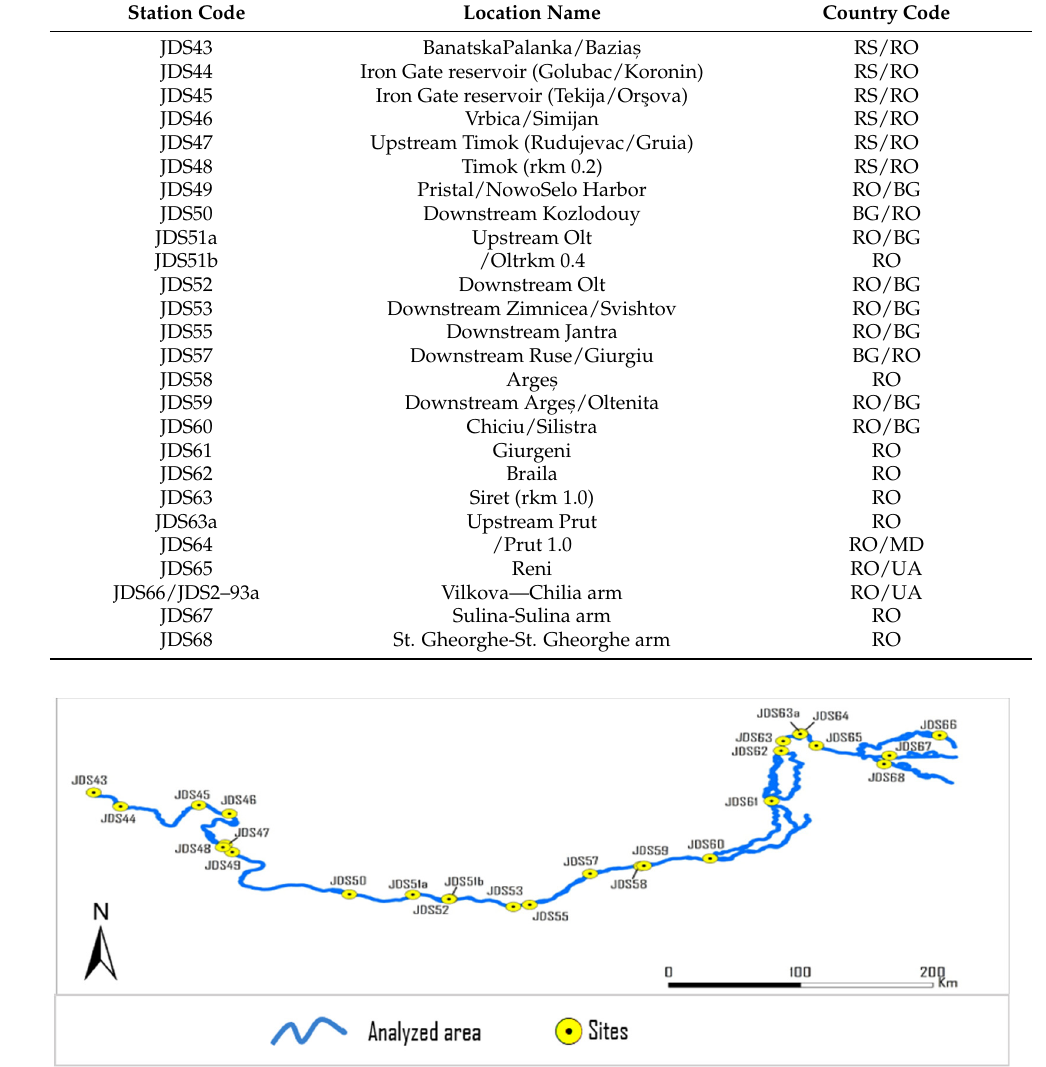
Table 3. Romanian Danube JDS3 (26) sampling stations (according to Liška et al. [54]).